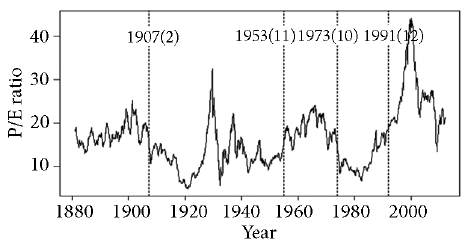
Figure 3. Structural breakpoints of PE10 – Bai-Perron